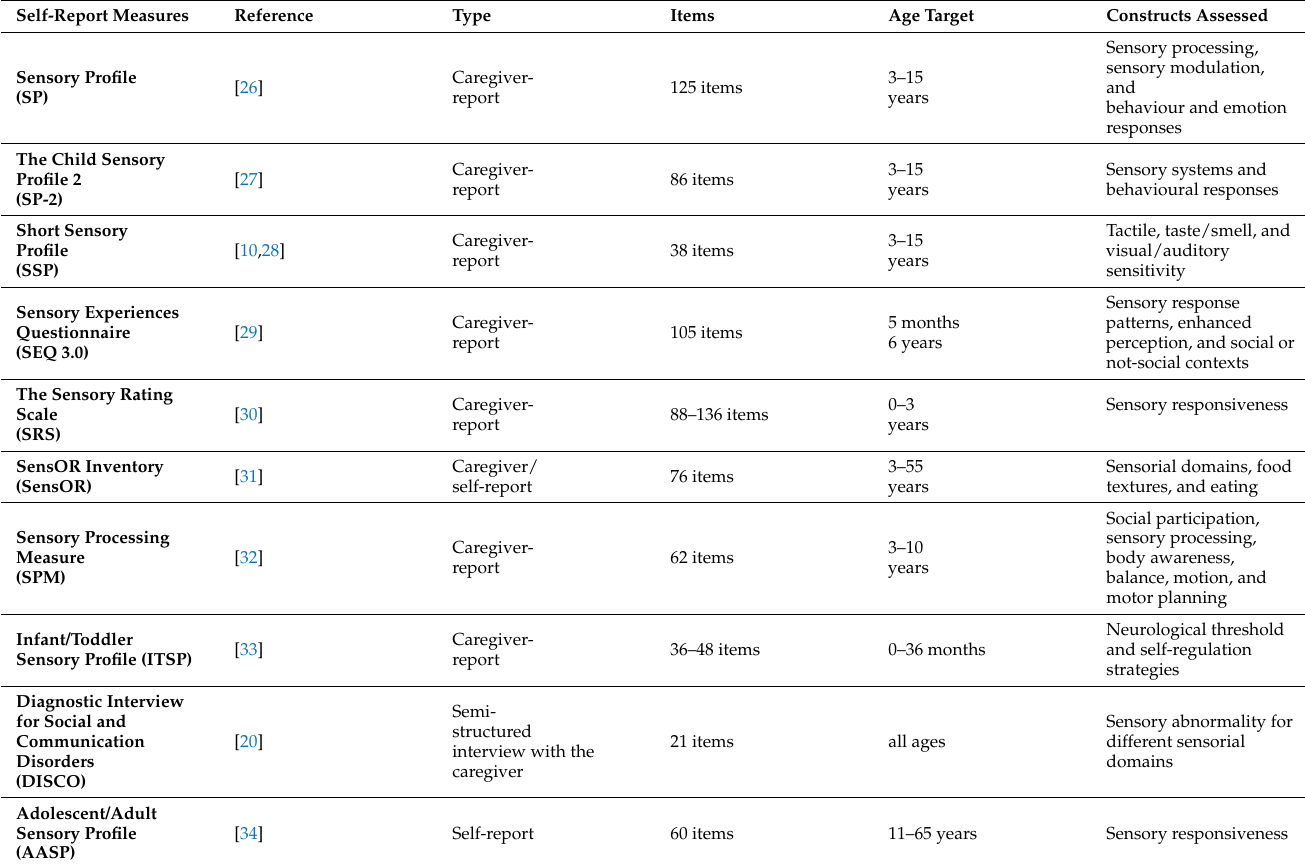
Table 1. Sum of the principal caregiver-/self-report questionnaires used to assess